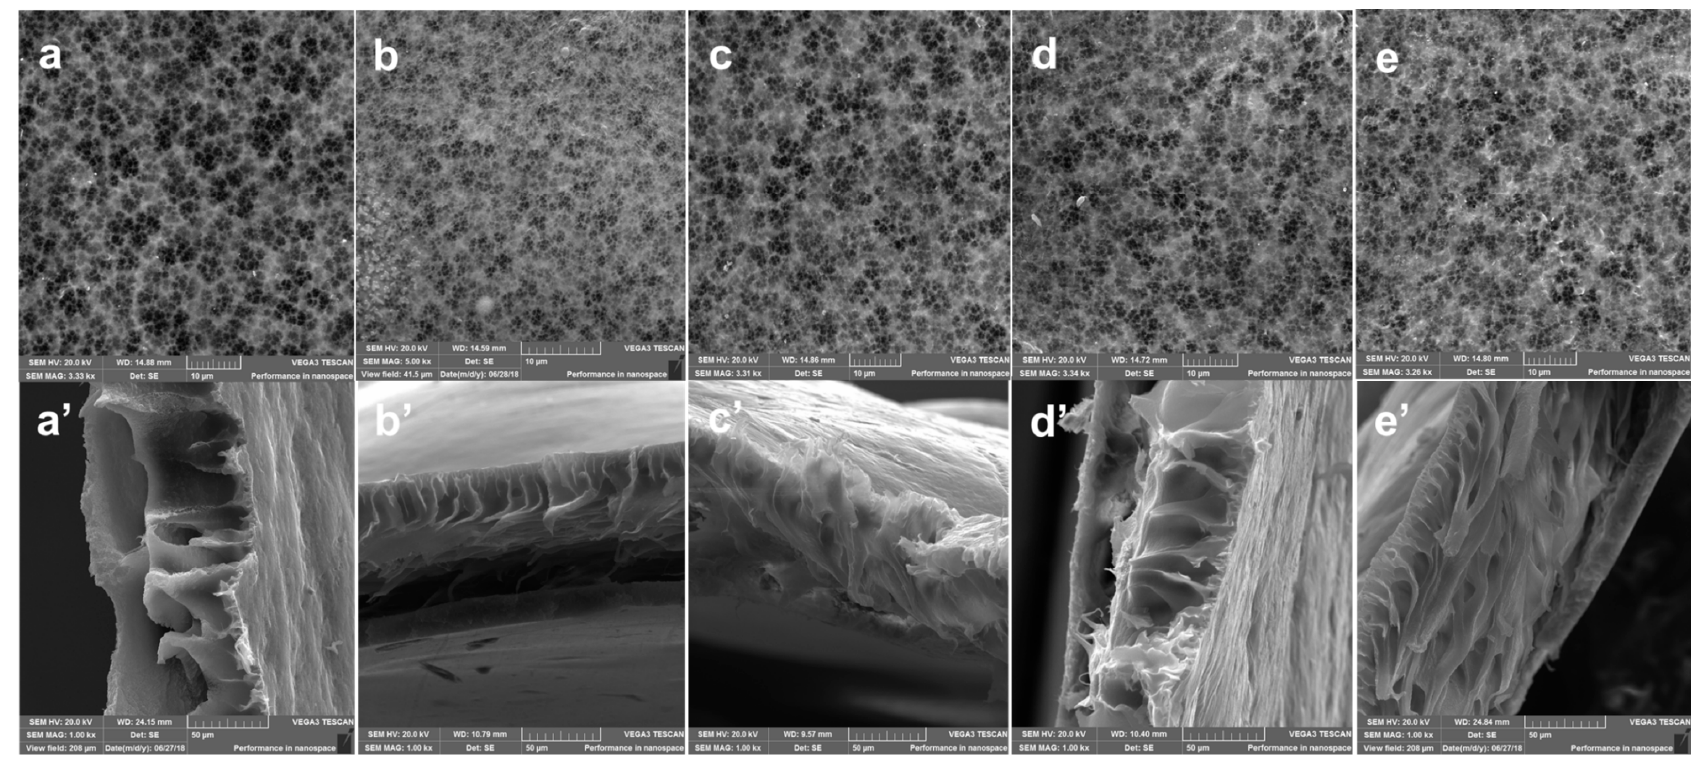
Figure 5. Surface and cross-section morphology of the prepared membranes.